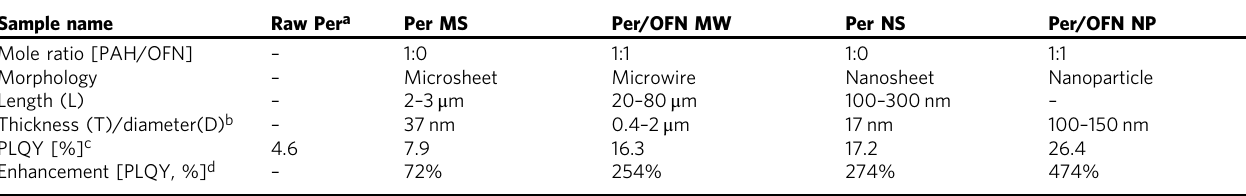
Table 2 Key information of the resultant